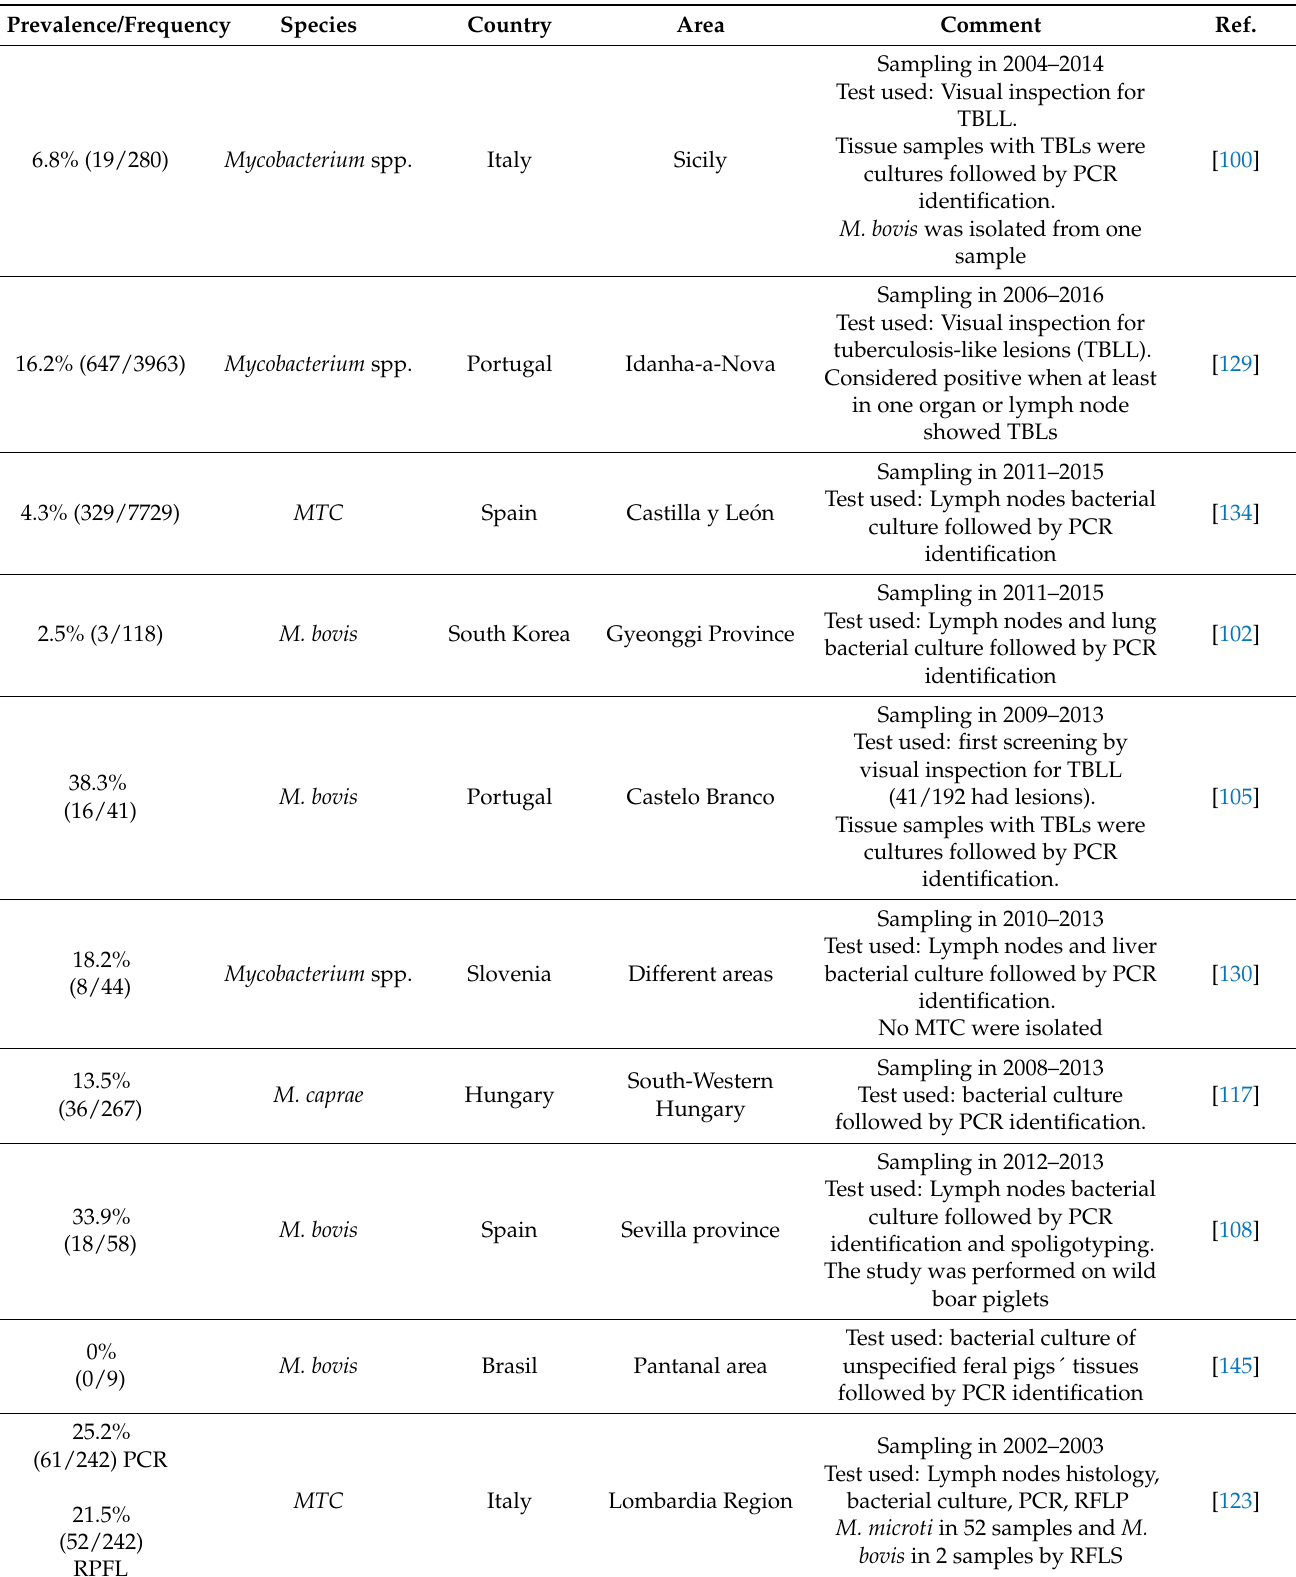
Test used: Lymph nodes histology, bacterial culture, PCR, RFLP M. microti in 52 samples and